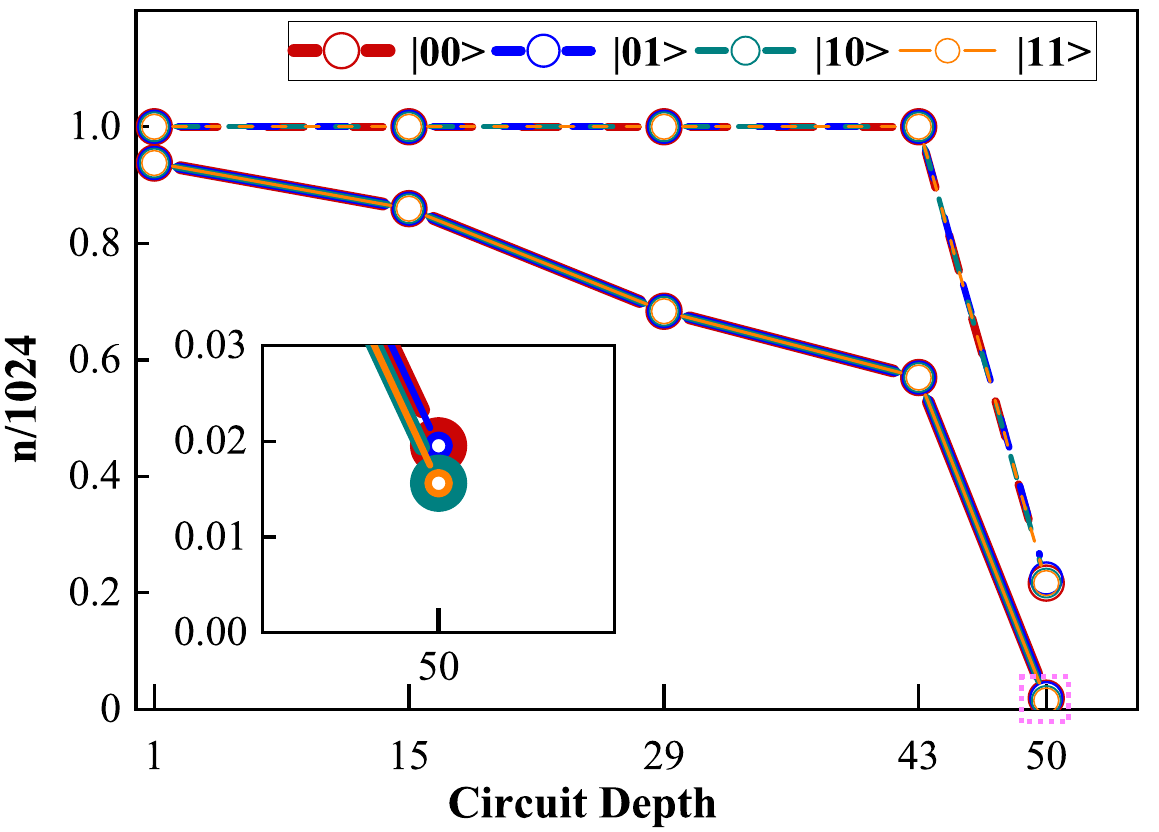
Figure 4. The ratio of the number of zero elements in the real part (solid lines) and that in the imaginary part (dashed lines) as a function of the quantum circuit depth. The inset presents the ratio of the final states after QFT †